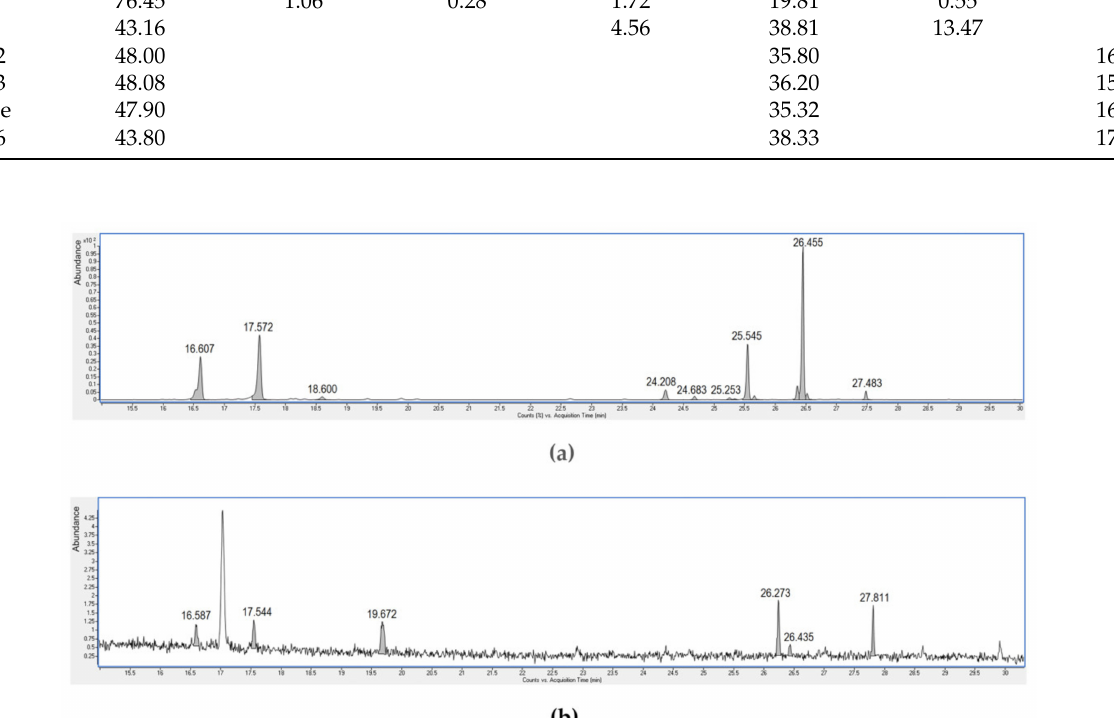
Figure 5. ( a ) Chromatogram of polysaccharide content of Neem gum; ( b ) Chromatogram for monosaccharide analysis of the MY33